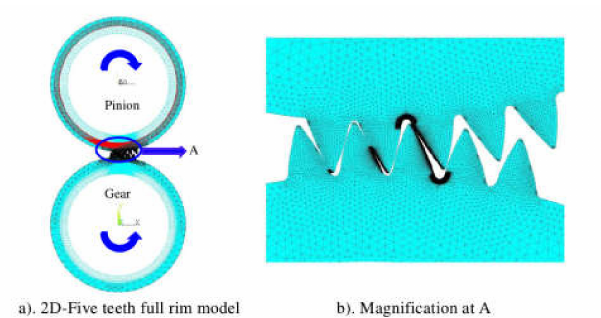
Figure 2. Finite-element model with boundary conditions for